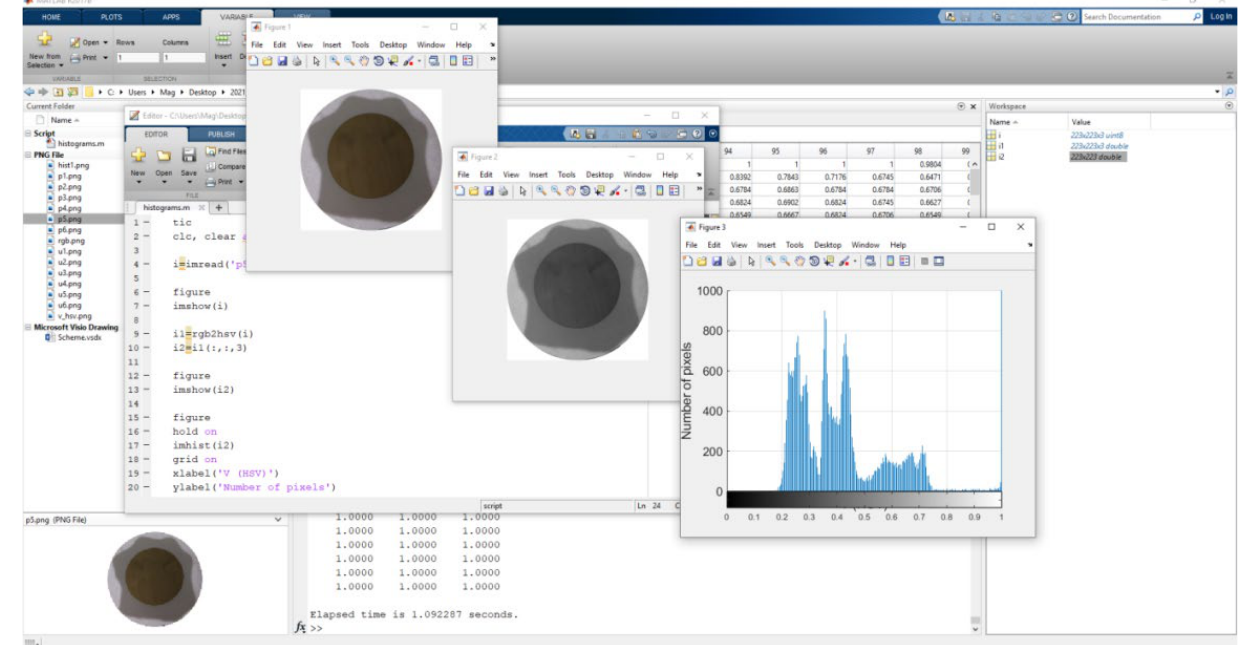
Figure 1. Image processing in Matlab environment.